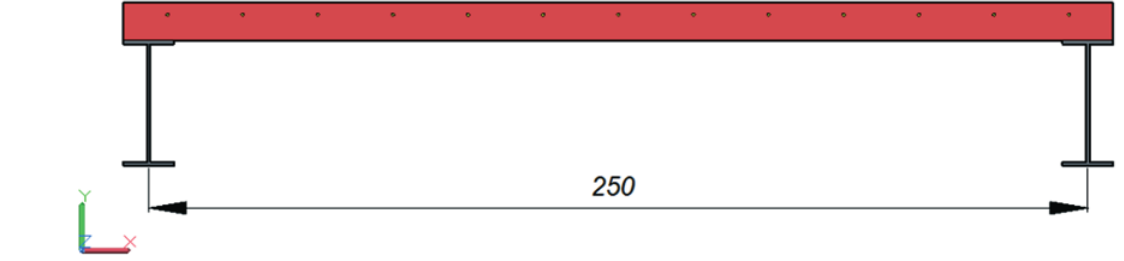
Figura 16 Modelo padrão – distância entre